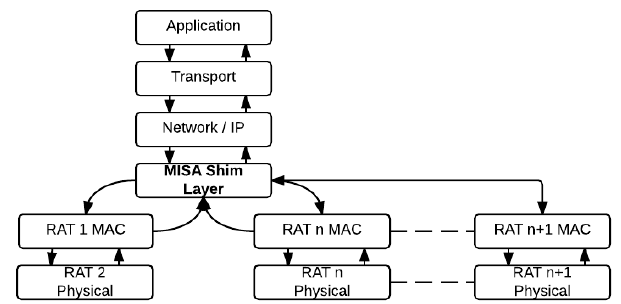
Figure 1. Conceptual Model of the Shim